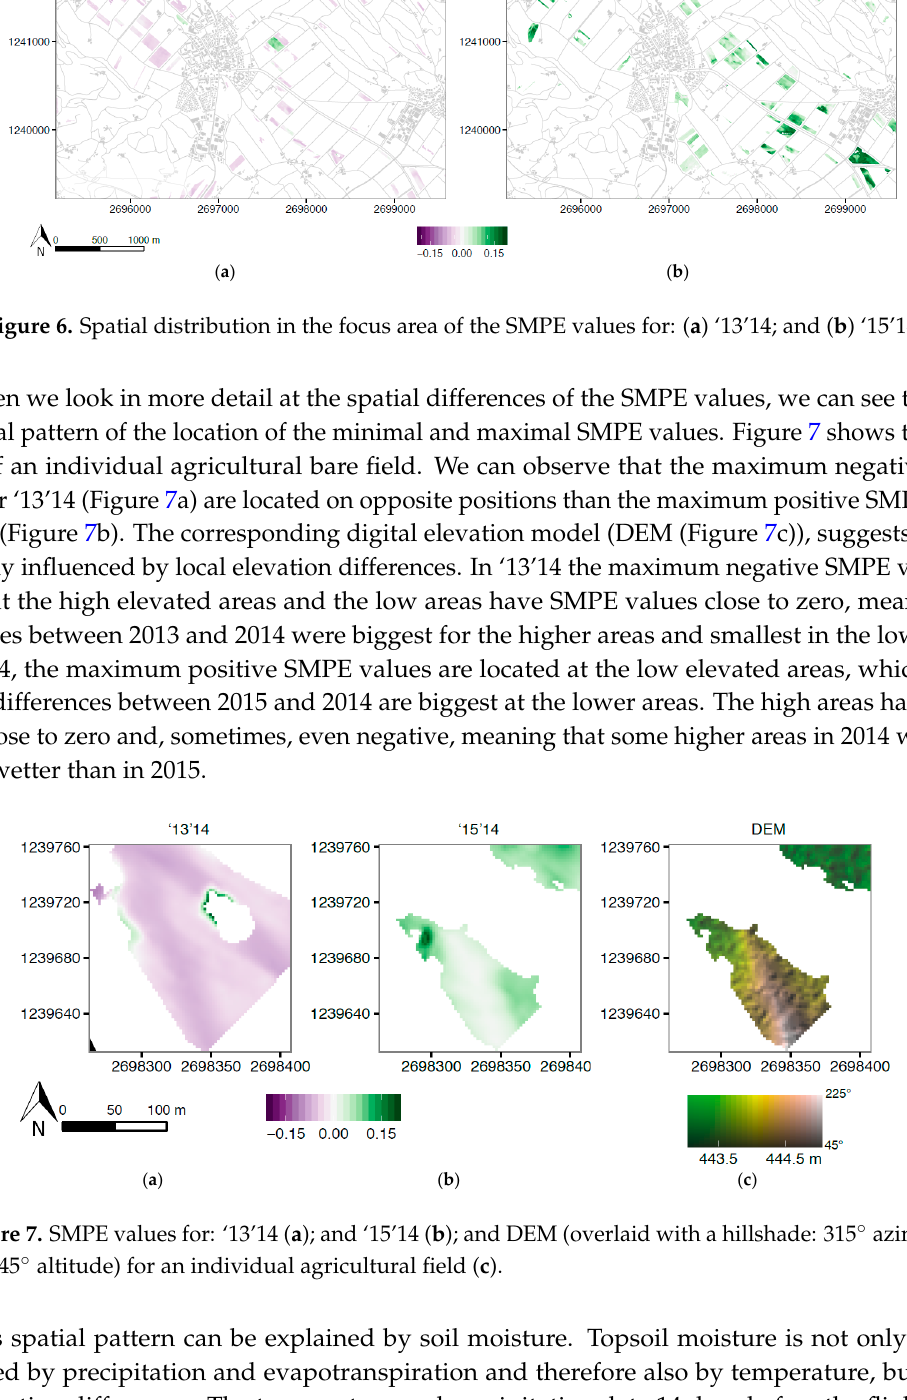
Figure 7. SMPE values for: ‘13’14 ( a ); and ‘15’14 ( b ); and DEM (overlaid with a hillshade: 315° azimuth and 45° altitude) for an individual agricultural field ( c ).